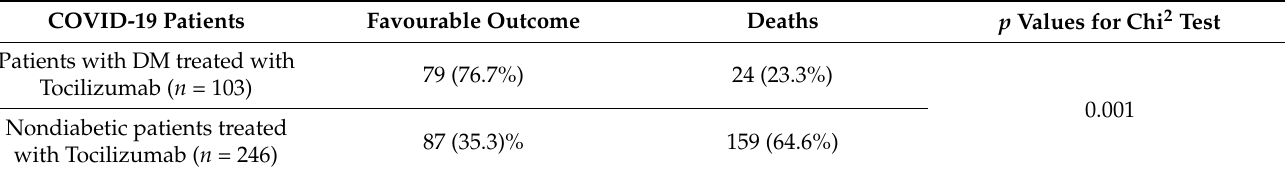
Table 8. Evolution of SARS-CoV-2 patients treated with